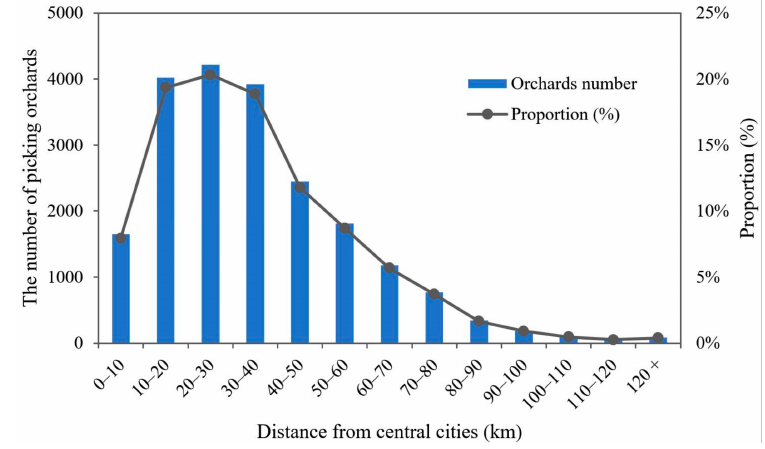
Figure 6. Gradient distribution of picking orchards from city centers (most picking orchards are located within 10–40 km of a city center).